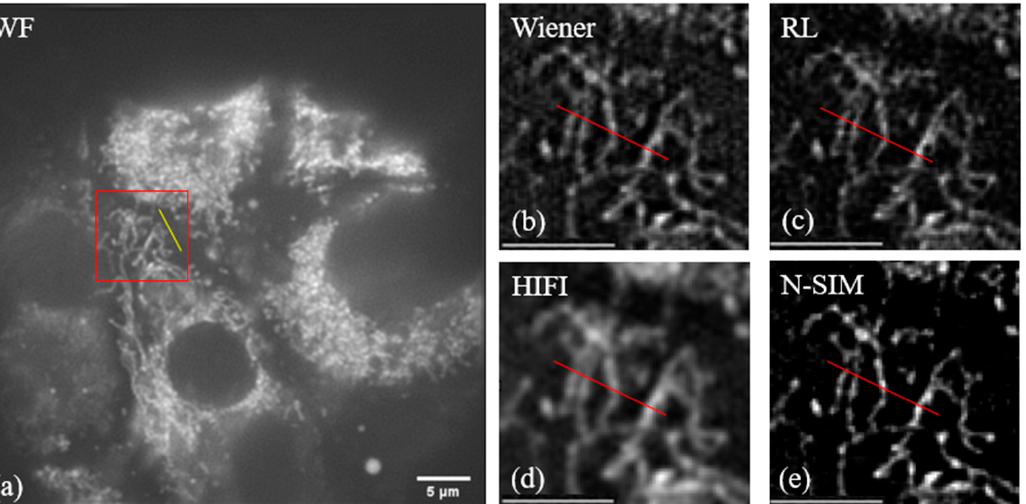
Figure 6. ( a ) a 60-fold objective lens is employed to collect the wide-field map of the sample; ( b ) imaging result reconstructed by Wiener-SIM; ( c ) imaging result reconstructed by RL-SIM; ( d ) imaging result reconstructed by HIFI-SIM; ( e ) imaging result reconstructed by N-SIM; ( b – e ) are magnified images of the square area in ( a ) with these four methods. The scale length in ( b – e ) is 5 μ m. The fluorescence intensity of the four reconstructed images was analyzed. The results are shown in Figure 7 below. It can be seen that the background of the image reconstructed by N-SIM algorithm was lower than that of the other three algorithms, and the quality of the reconstructed image was higher than that of the other three reconstruction methods.